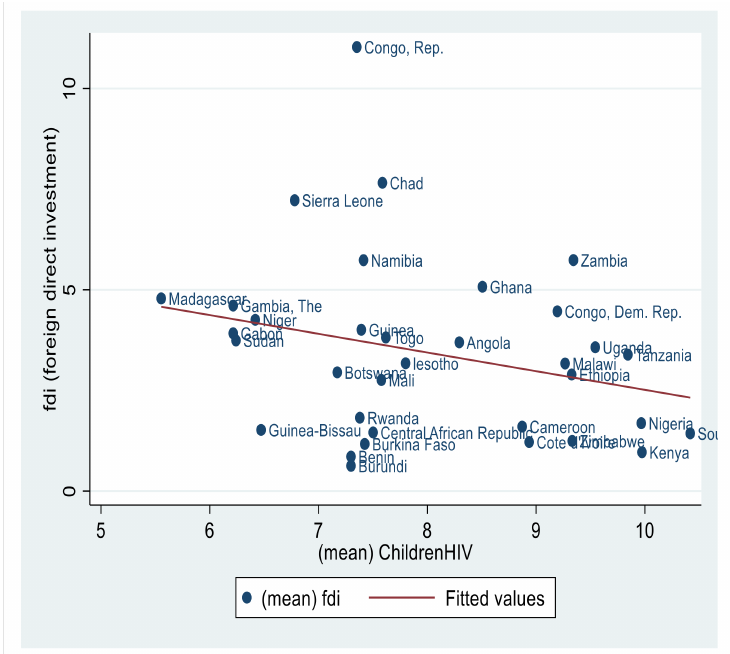
Figure 8. Children newly infected with HIV and FDI.